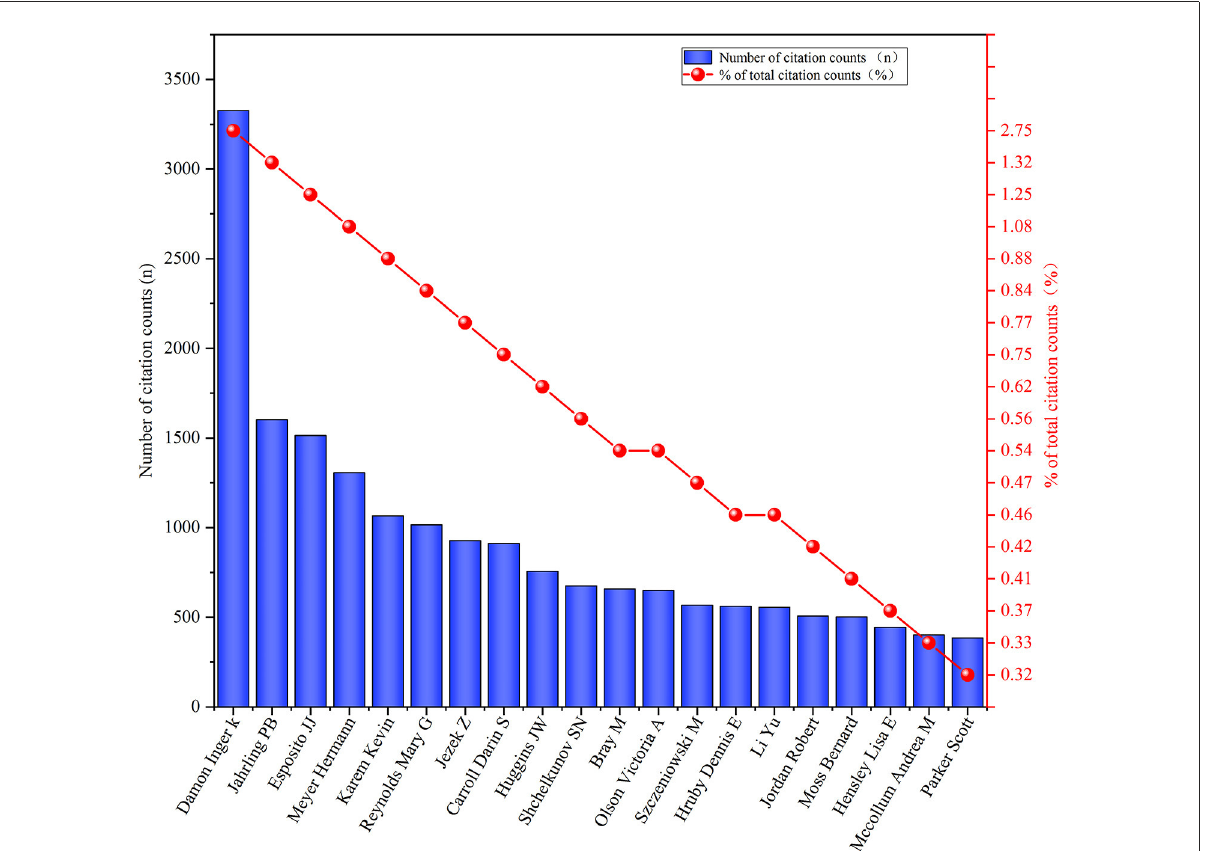
FIGURE6 Top 20 authors with most-cited papers in the field of monkeypox. The Y-axis on the left indicated the number of citation and the right indicated the proportion of the total